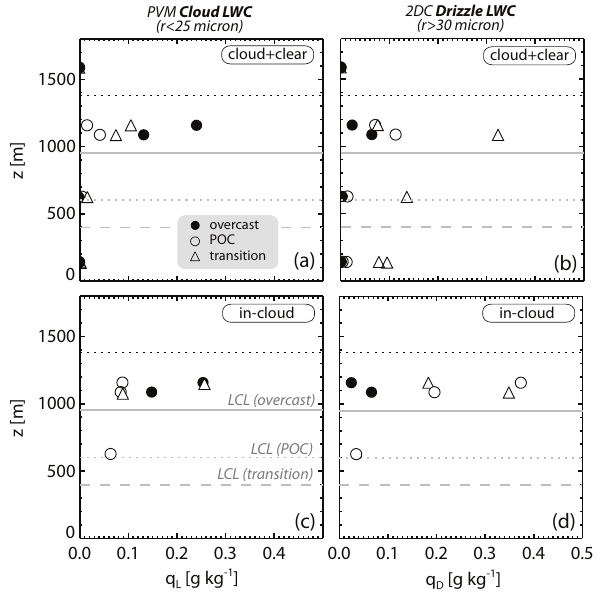
Fig. 8. Profiles from RF06 of mean values of cloud (a,c) and drizzle (b,d) liquid water content from straight and levels runs (symbols) in the POC, overcast, and transition regions. The upper panels (a,b) give values averaged over both cloudy and clear portions of the legs, while the lower panels (c,d) show values averaged over cloudy samples only. Note that there is little difference between the cloud + clear and in-cloud values for the overcast region since the runs were either almost entirely in cloud or entirely out of cloud.